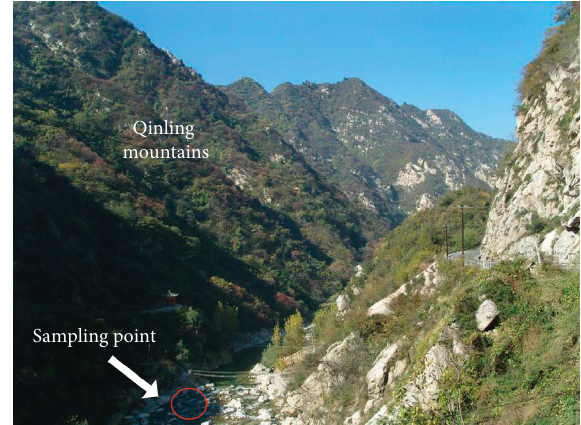
Figure 7: Location map of the sampling